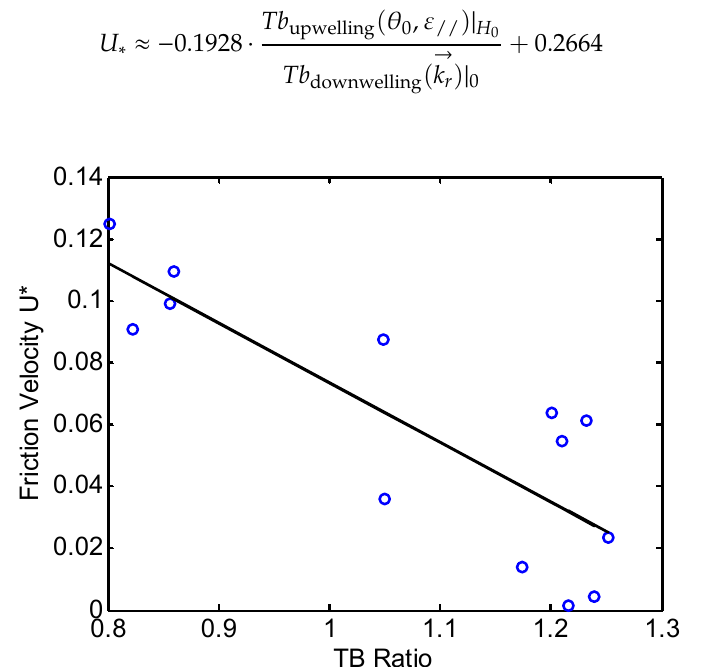
Figure 8. Friction velocity vs. TB ratio. The circles are the observed data on 21, 23 October 2018. The line in the figure was obtained by fitting the observed data using the least square method.